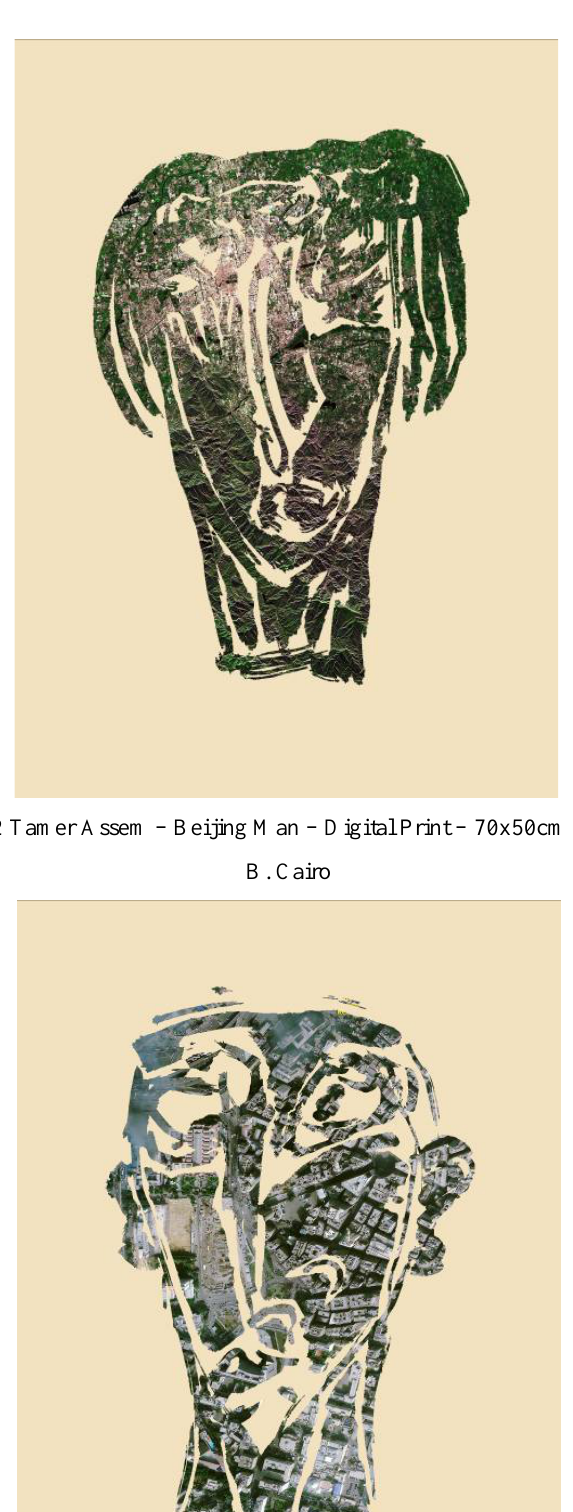
Figure 1 Tamer Assem – Beijing Man – Digital Print – 70x50cm – (2017)